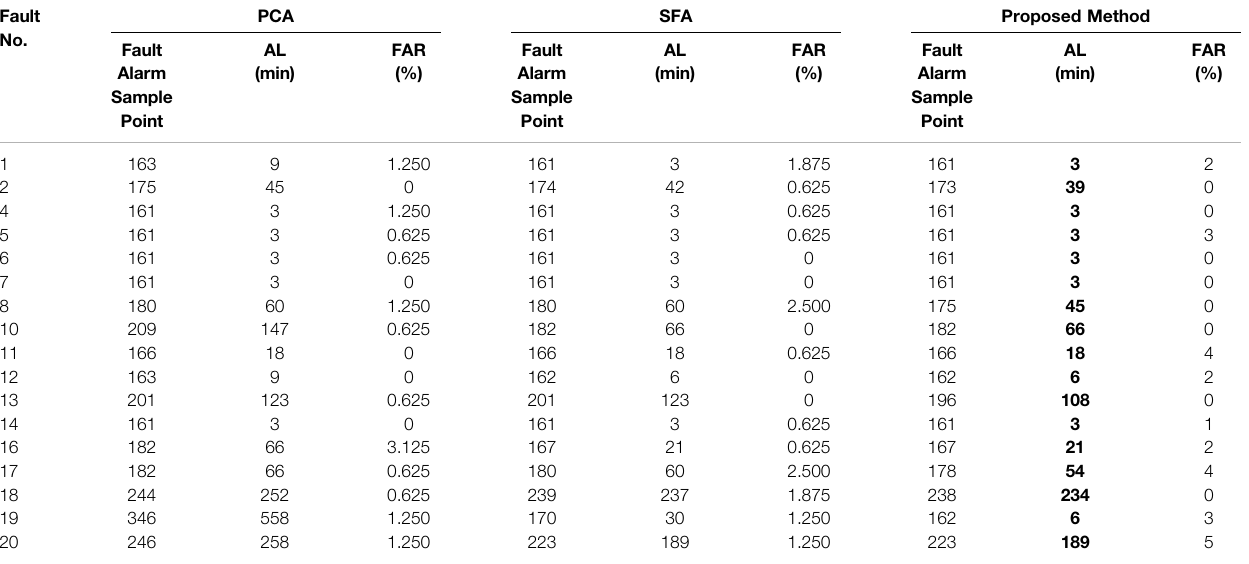
TABLE 3 | Fault alarm results of PCA, SFA and the proposed method in the TEP dataset. Fault